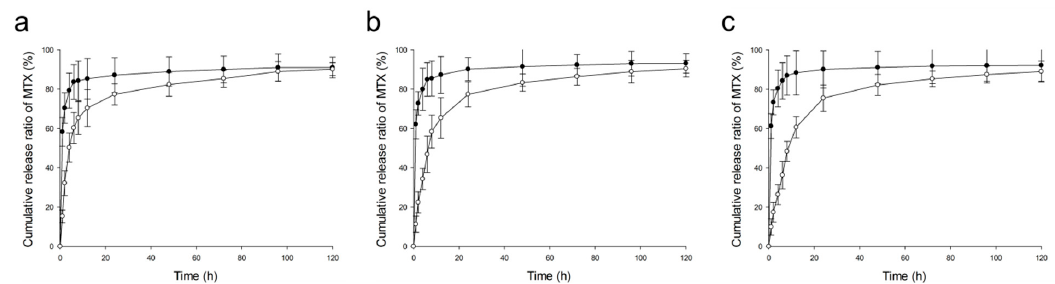
Figure 8. In vitro drug release profiles of free MTX (- ● -) and MTX-loaded PLGA NPs (- ○ -) in various